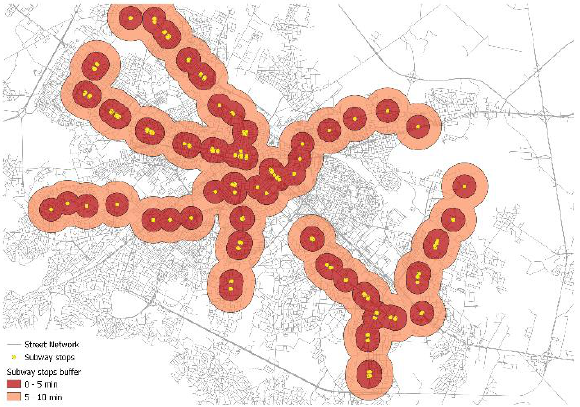
Figure 7. Buffer service area of subway stations.